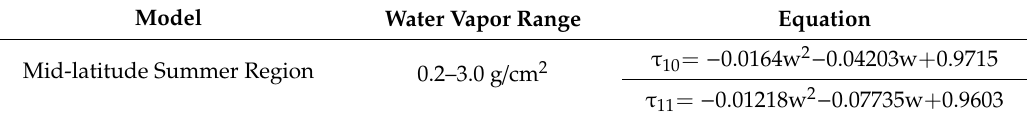
Table A4. The relationship between atmospheric transmittance ( τ 10 / 11 ) and water vapor content (w). Model Water Vapor Range